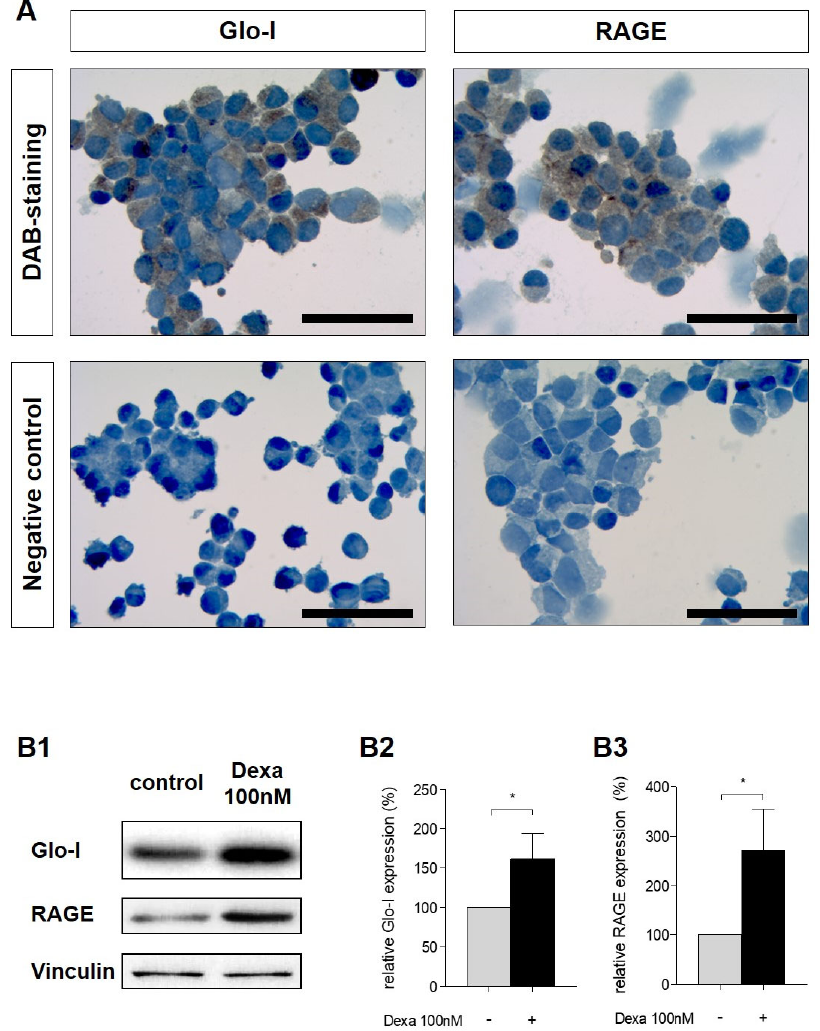
Figure 2. Expression of Glo ‐ I and RAGE in AR42J and effect of dexamethasone. ( A ) Representative Glo ‐ I ‐ and RAGE ‐ DAB ‐ staining images of AR42J cells stained using cytospin. Negative controls lack the primary antibodies. Images indicate ubiquitous cytosolic Glo ‐ I protein expression and predominant membrane RAGE protein expression. ( B1 – B3 ) effect of dexa on Glo ‐ I and RAGE staining intensity. After 48 h, dexa significantly increased protein levels of Glo ‐ I and RAGE, as indicated by Western blot ( B1 ). Quantifications ( B2 , B3 ) were calculated of at least three independent experiments and are expressed as mean ± SD. * p < 0.05. Scale bars: 100 μ m. Dexa: dexamethasone, DAB: Diaminobenzidin.